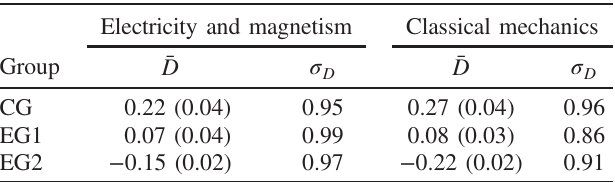
TABLE V. The number of standard deviations each group ’ s final grade average was from the class average [ Eq. (1)] when these students took two other nontransformed upper-division physics courses. The standard error of in parentheses. Also of note is that the standard deviation of the D values are very close to 1 in units of σ , the standard deviation i of the final grade distribution. This indicates that these subsets of students (the control and experimental groups) were distributed in much the same way and thus not atypical of the overall class distribution